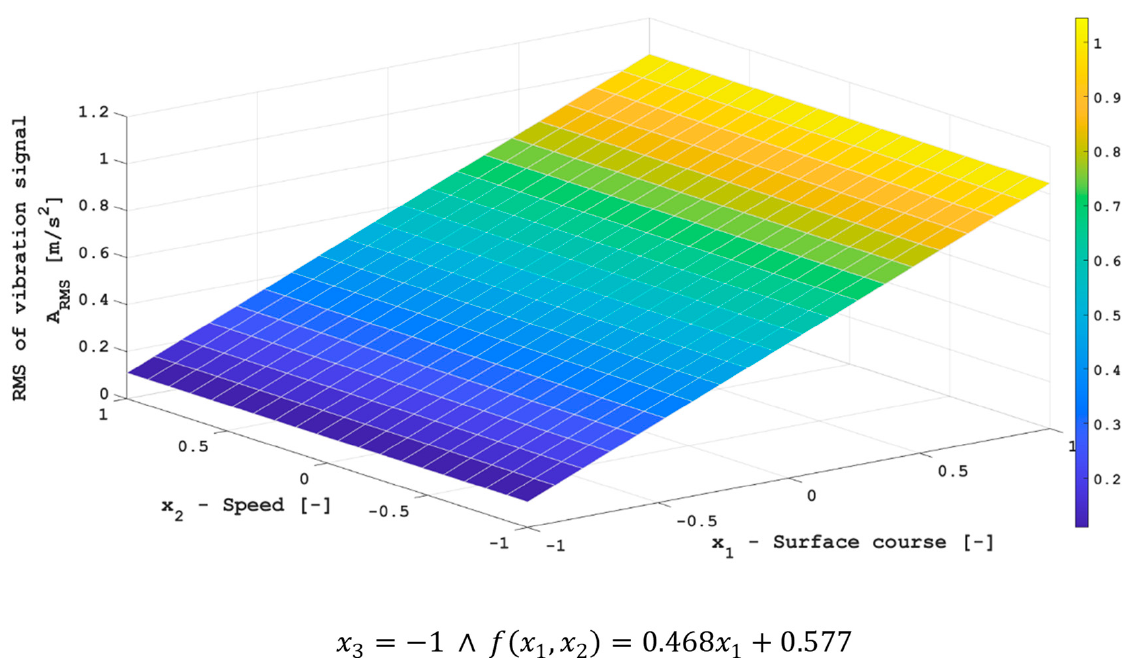
Figure 9. A RMS signal values, depending on the surface course and the speed of the electric scooter when covering a distance of 1 km.